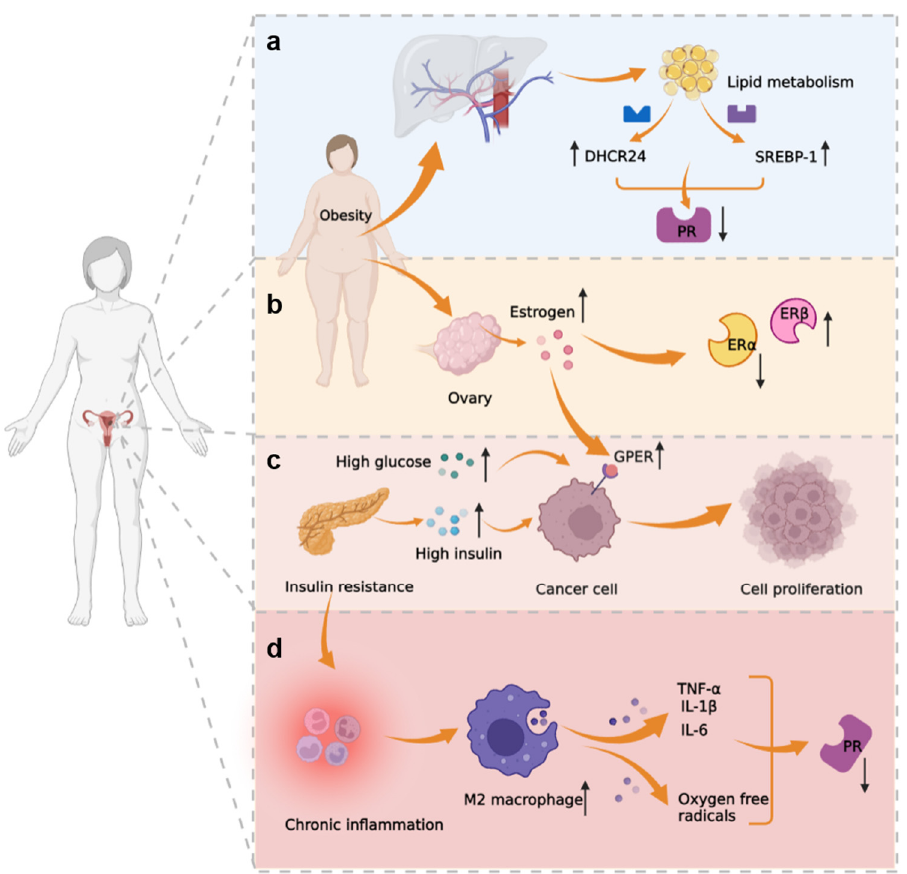
Figure 3. Mechanism of progestin resistance related to metabolic-immune-tumor microenvironment. ( a ) Lipid metabolism-related enzymes SREBP-1 and DHCR24 regulate PR expression. ( b ) Obesity promotes estrogen production in ovaries. In progestin-resistant EC cells, ER α expression is downregulated and ER β expression is increased. ( c ) Obesity, insulin resistance, and high glucose levels can upregulate GPER and make tumor cells more estrogen-sensitive. ( d ) Infiltration of M2 macrophages is more common in EC, and through secreting TNF- α , IL-1 β , IL-6, and oxygen free radicals, they can suppress PR expression.